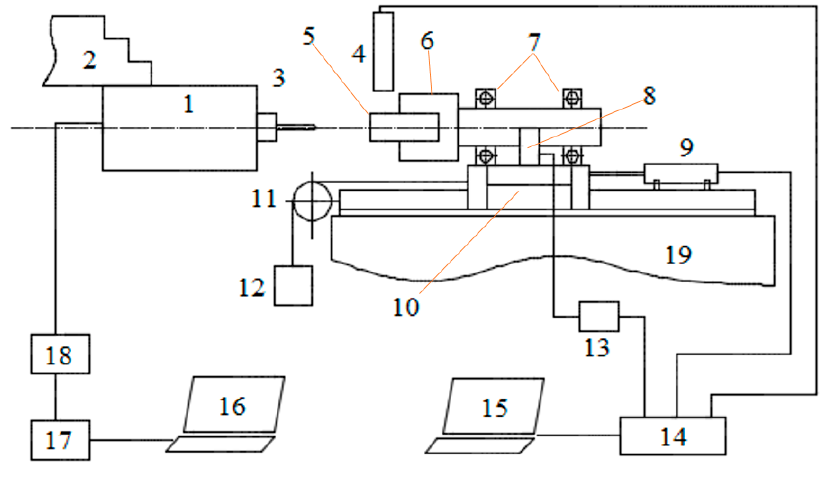
Figure 1. Experimental schema.